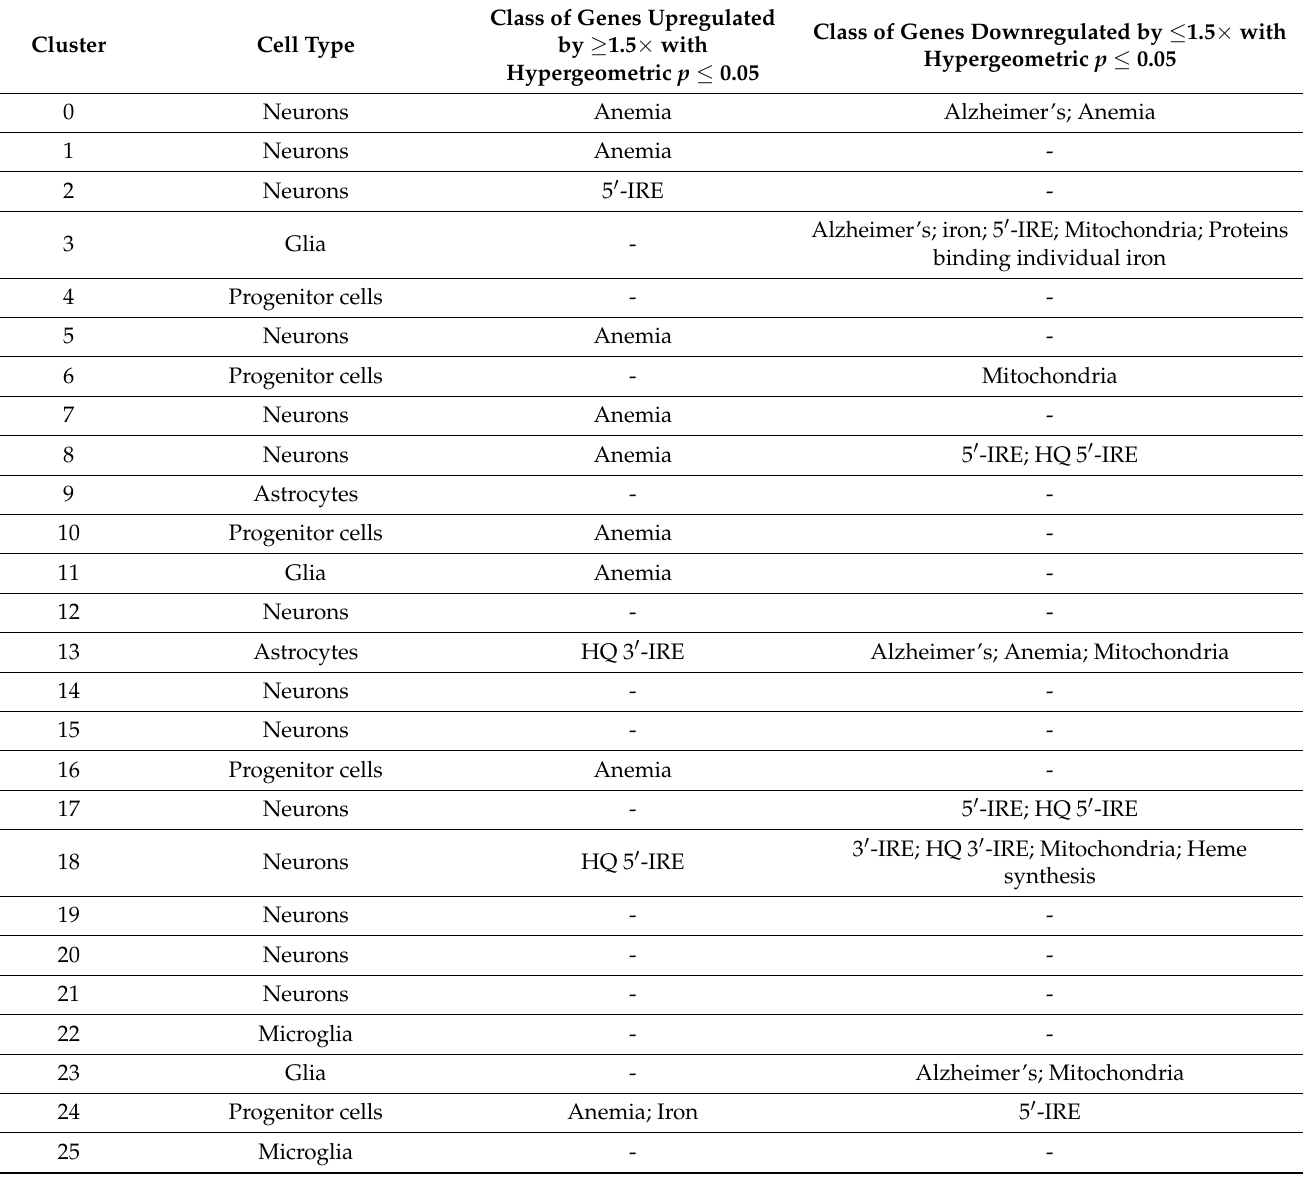
Table 3. PITRM1 KO vs. WT Cerebral Organoids from Induced Pluripotent Stem Cells— Individual Clusters